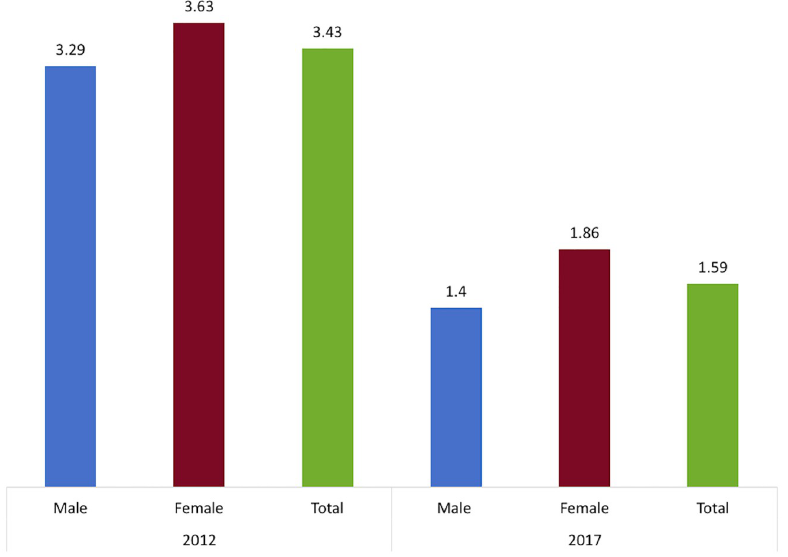
Fig 10. Change in HIV incidence in the RCSS. RCSS: Rakai Community Cohort Study. The numbers represent the incidence reported as percentage (%).